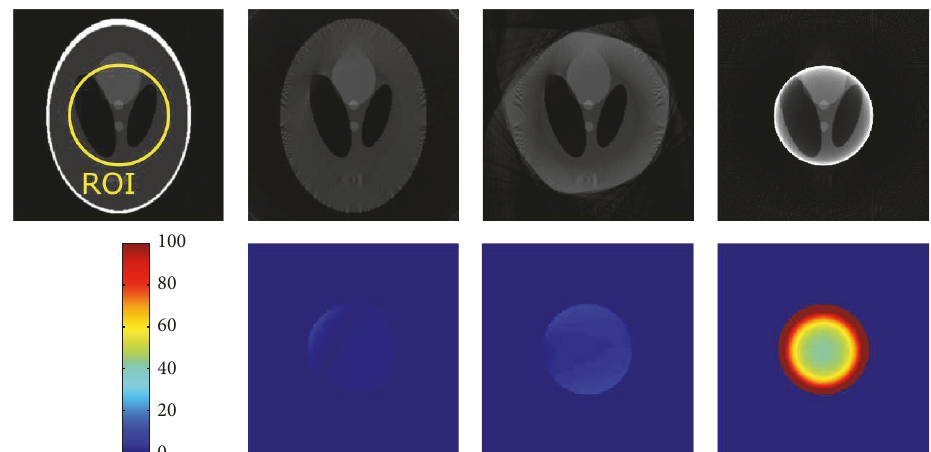
Figure 3: Reconstruction results of Shepp-Logan phantom (radius of ROI: 60 pixels). From left to right: reference from nontruncated data, proposed correction method, water cylinder extrapolation (cf. Hsieh et al. [2]), and no correction. The grayscale window is [0,1] .